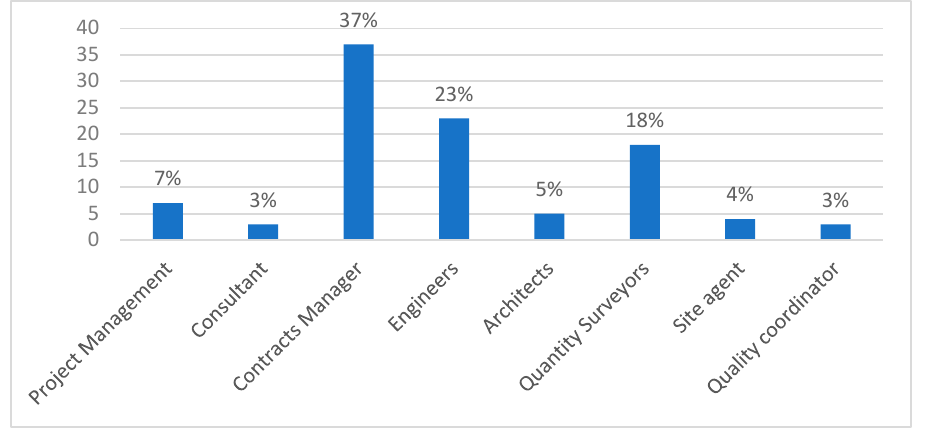
Figure 3. Respondents’ professional qualification.